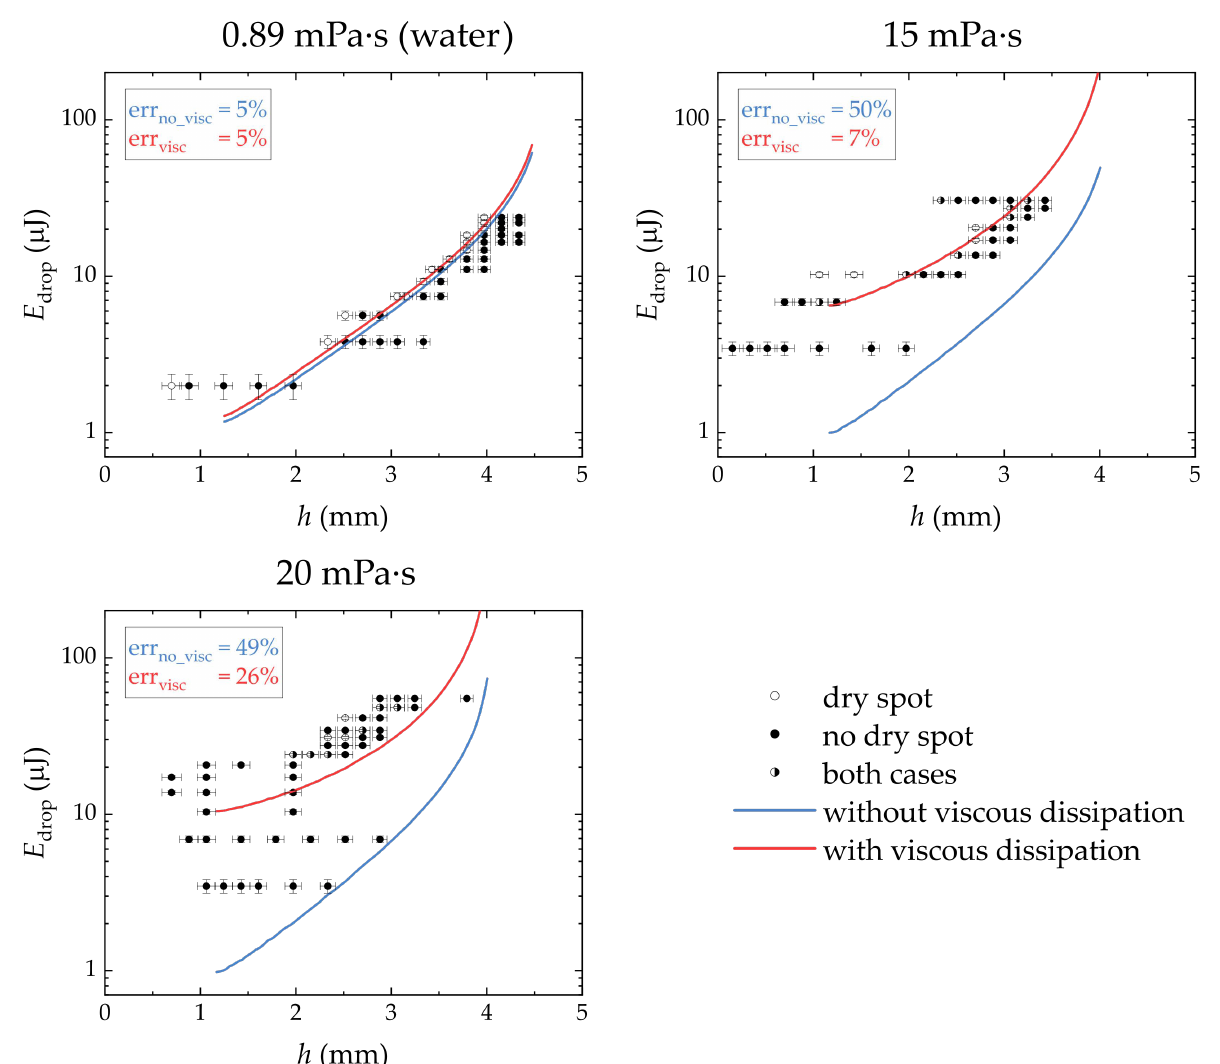
Figure 3. Energies of falling droplets, E drop , leading or not to the formation of stable holes in the liquid films versus their thickness, h . Liquids are water (Data from [17]) and aqueous glycerol solutions. A joint legend outside the plots shows the notation of markers and lines. Legends inside of the plots present the separation errors of the crater model without and with the viscous dissipation of energy (blue and red fonts,